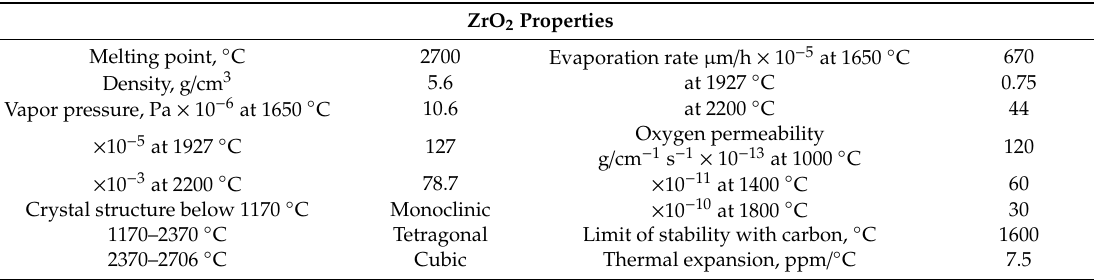
Table 2. ZrO 2 properties